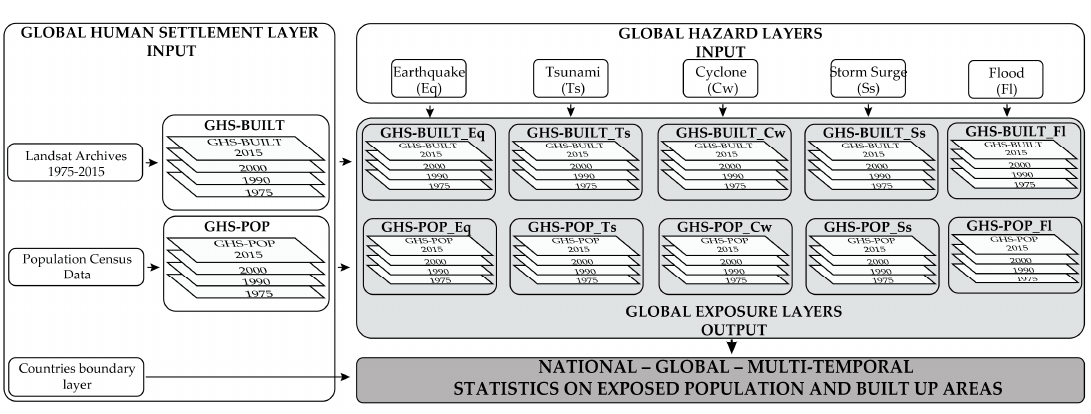
Figure 1. Schematic overview of all input datasets (white boxes), Global Human Settlement and hazard maps, and the resulting exposure datasets produced (shaded boxes).